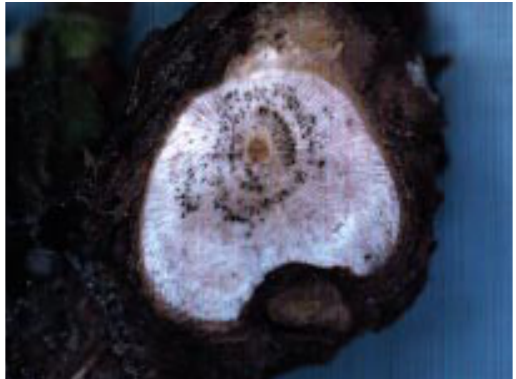
Fig. 1. Black goo decline symptoms in trunk of Schwartz- mann rootstock mother vine, positive for Phaeoacremo- nium chlamydosporum .